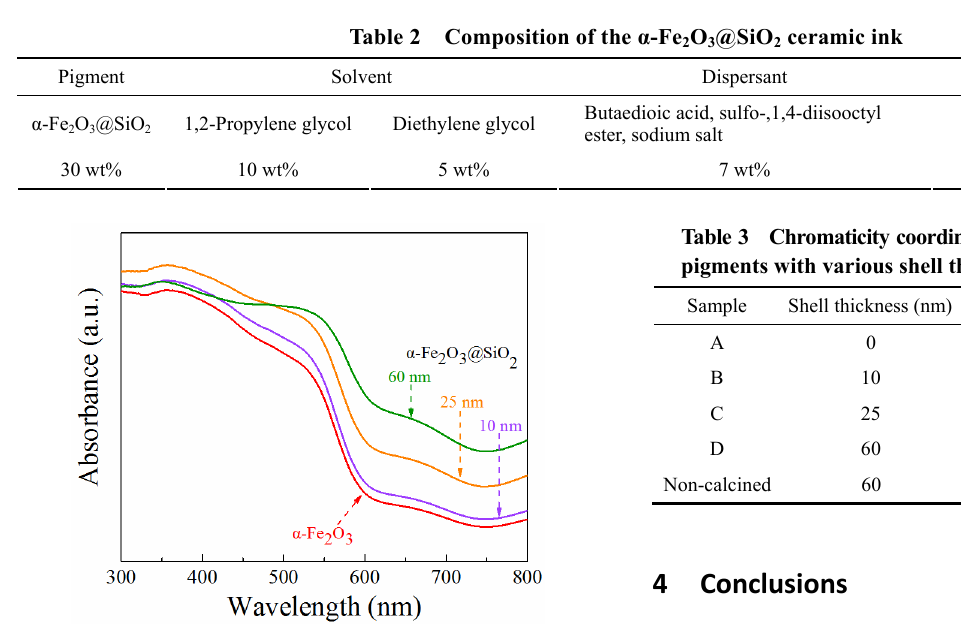
Fig. 9 UV–Vis spectra of the α-Fe 2 O 3 and α-Fe 2 O 3 @SiO 2 pigments with various shell thickness.